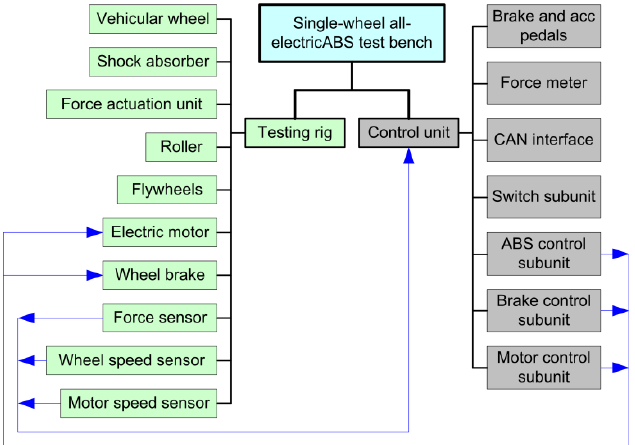
Figure 1. Block diagram of proposed single-wheel all-electric ABS test bench.